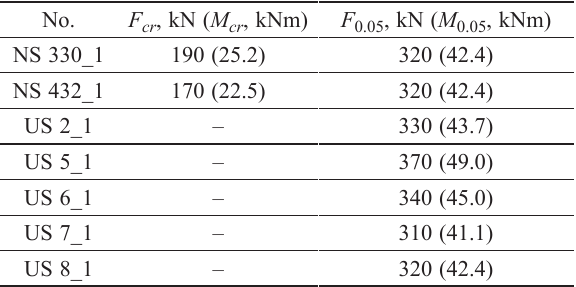
Table 3. Summary of static test results No.